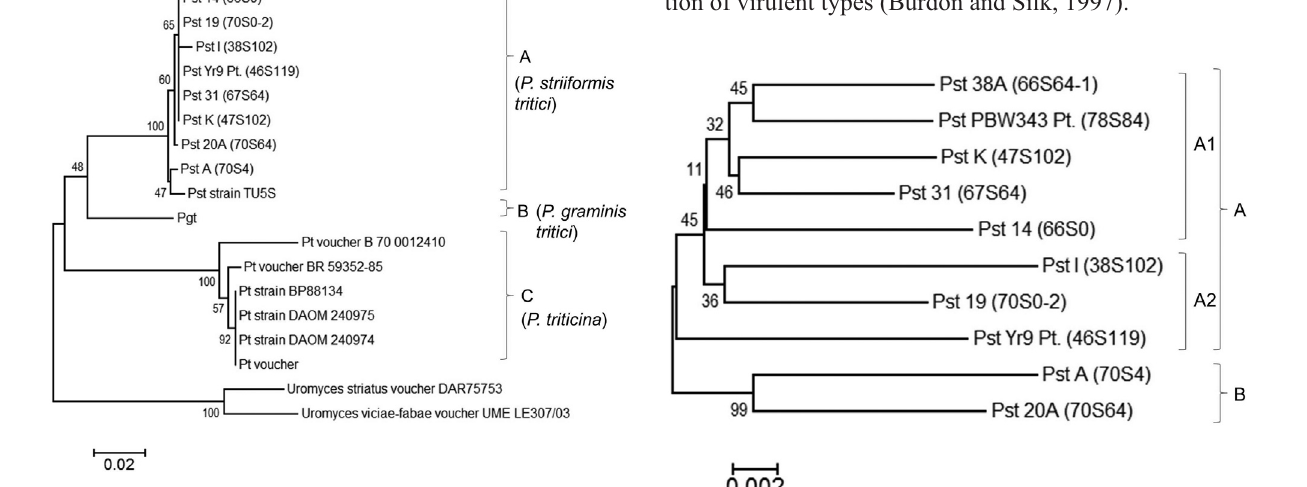
Figure 3 - Neighbor-joining tree based on nucleotide sequence of (cid:2) -tubulin showing phylogenetic relations among pathotypes of P. striiformis tritici , P. graminis tritici , and P.triticina